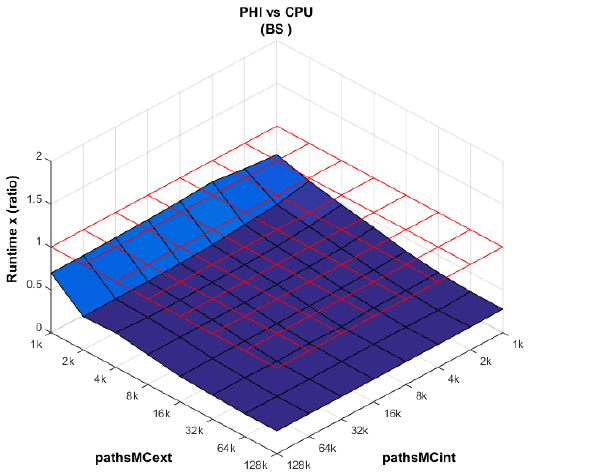
Figure 8. Runtime scaling: XeonPhi vs. CPU, given as a ratio between platform X vs. platform Y, (X/Y). The red-colored grid shows the point where both platforms would achieve the same runtime. Above this grid, runtime X is larger than runtime Y, and vice versa.